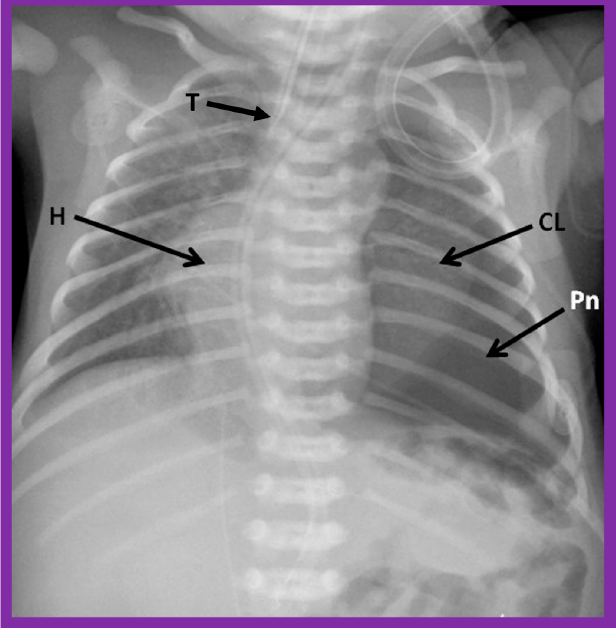
Figure 6. A chest roentgenogram of a baby illustrating dextroposed heart (H) due to left pneumothorax (Pn) pushing the heart into the right side of the chest. A collapsed left lung (CL) is pointed out. The trachea (T) is seen to deviate to the right. Modified from reference [4].